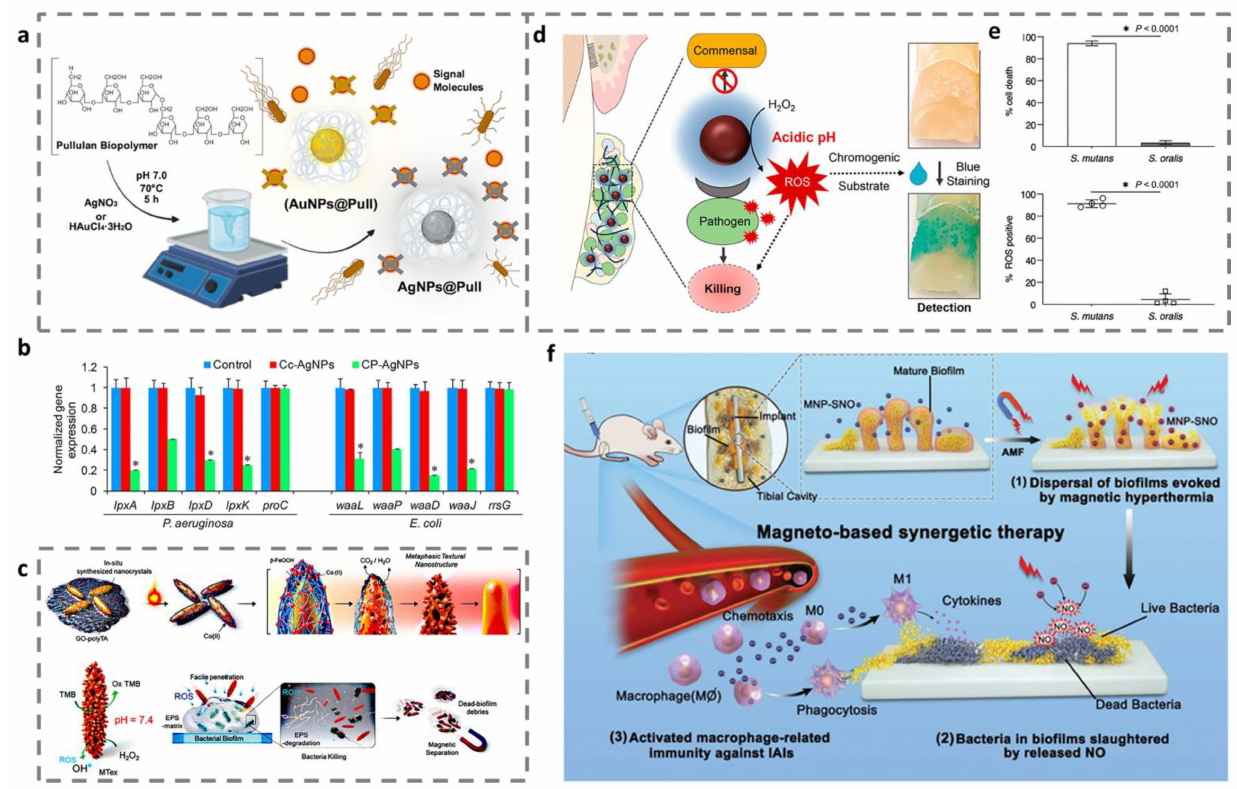
Figure 11. Metal and metal oxide nanomaterials remove biofilm by blocking quorum sensing and killing bacteria. ( a ) The preparation scheme of Ag NPs@Pull and Au NPs@Pull and their quo- rum sensing inhibition. ( b ) The expression of virulence factor-related genes. * p < 0.001